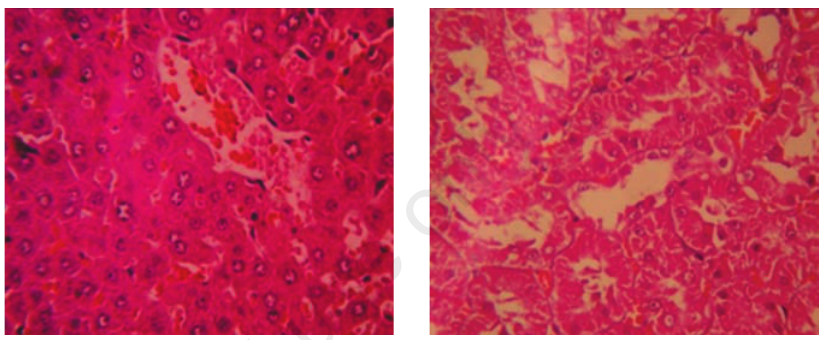
Figure 6. Kidney of Kushta Sammulfar -I showing normal capsule and glomeruli.